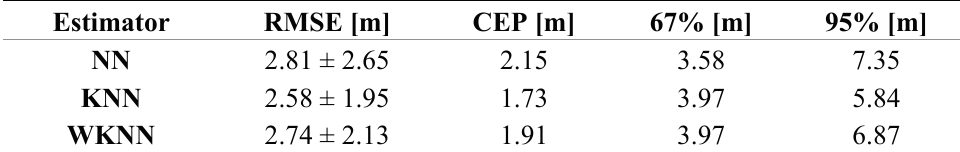
Table 7. Accuracy of modular positioning system in the indoor environment.